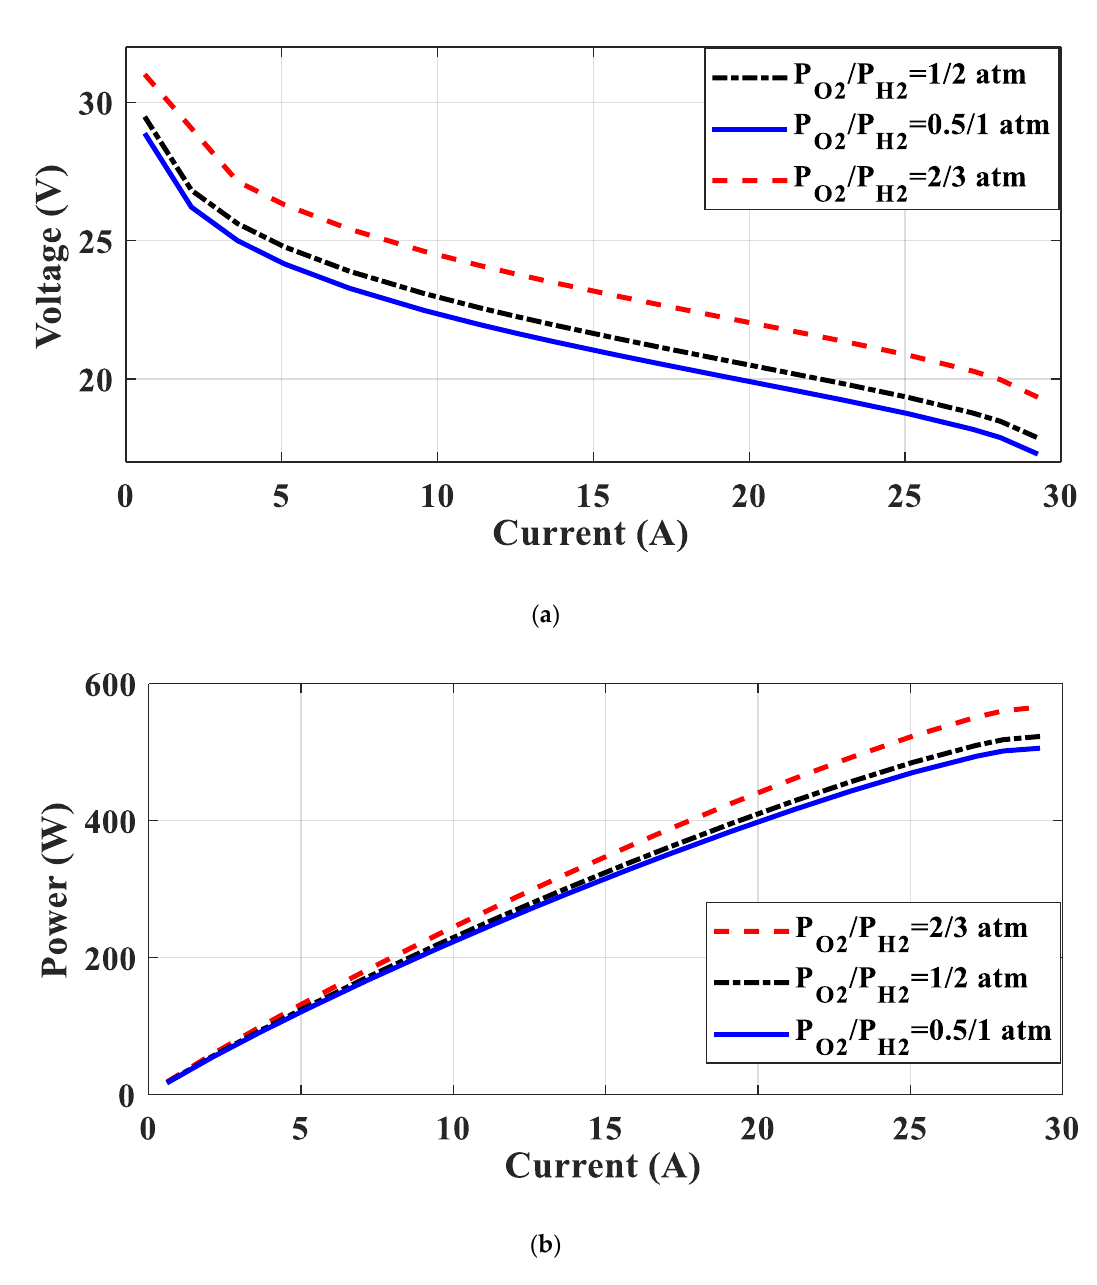
Figure 9. Polarization curves of Ballard fuel cells using the HGS algorithm under various pressure conditions at constant temperatures. ( a ) I–V curves. ( b ) I–P curves.